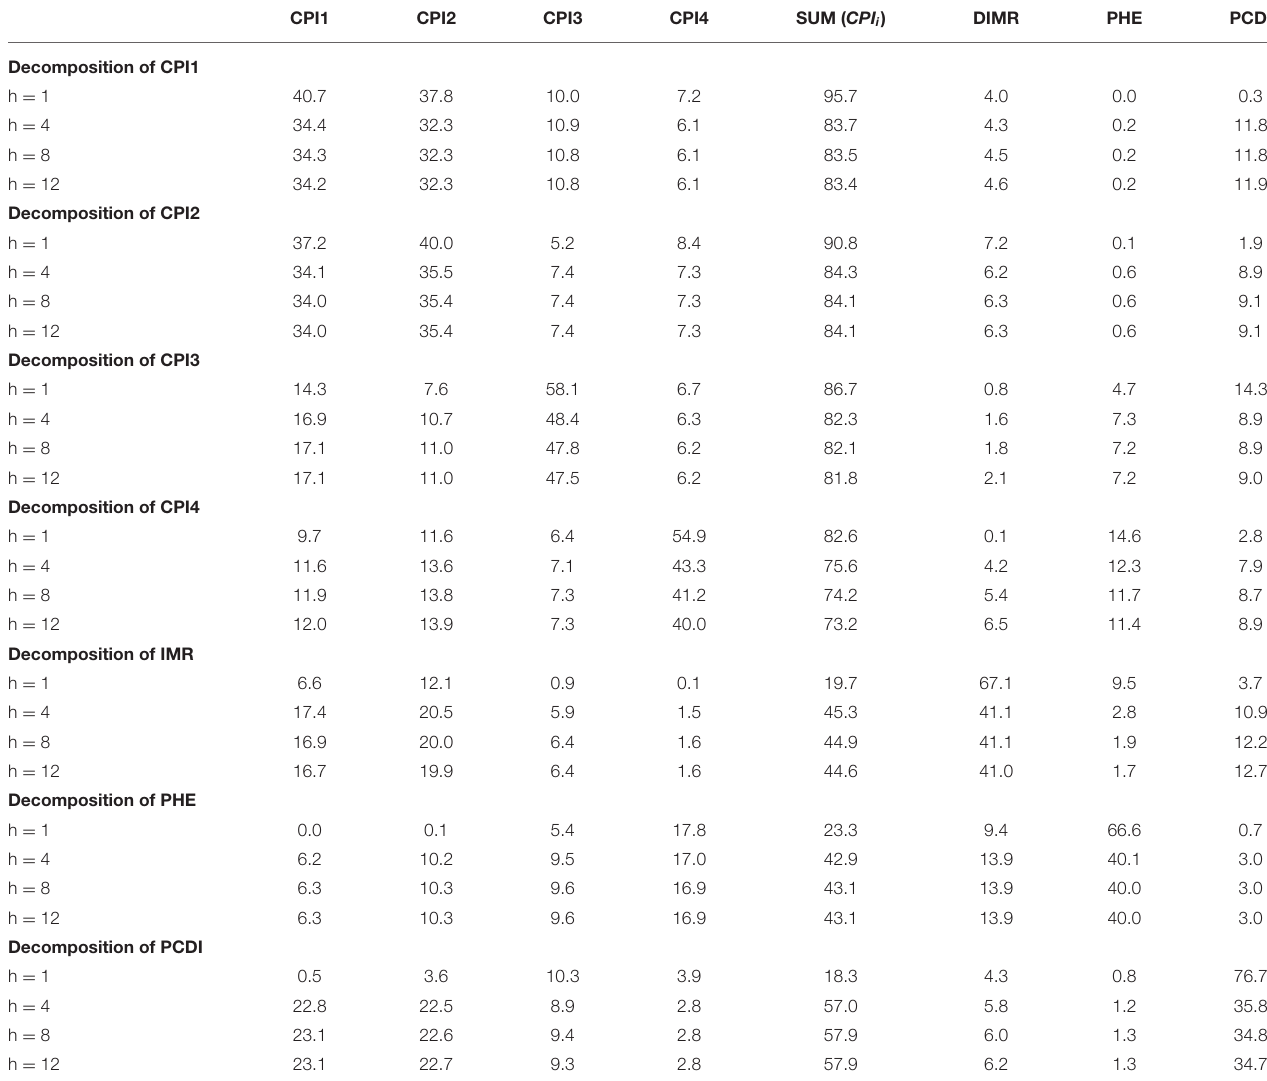
TABLE 5 | Forecast error variance decomposition of MF-VAR. CPI1 CPI2 CPI3 CPI4 SUM ( CPI i ) DIMR PHE